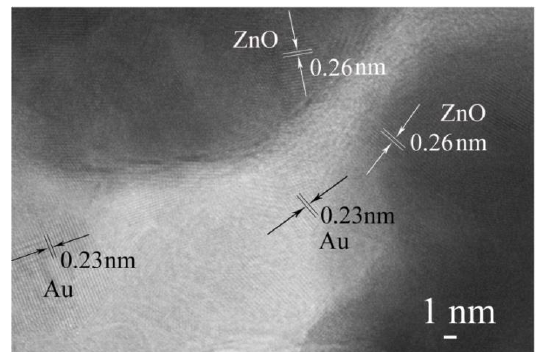
Figure 3. TEM images of hybrid ZnO/AuNPs nanorods (Sample 3).